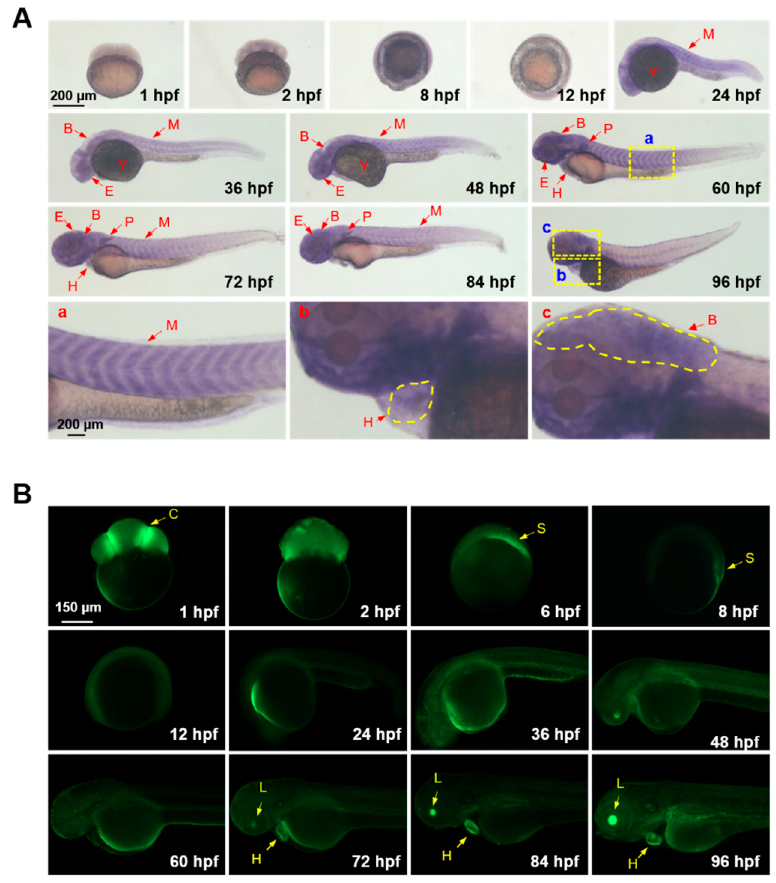
Figure 2. GCaMP6s expression and Ca 2+ signaling activity in embryos and larvae of the transgenic zebrafish. ( A ) Spatiotemporal expression patterns of GCaMP6s analyzed by whole-mount in situ hybridization. The magnified images indicate the expression of GCaMP6s in the myotome ( a ), heart ( b ) and brain ( c ). ( B ) Fluorescent microscope images indicating Ca 2+ signaling activities in the anatomical structures of zebrafish embryos and larvae. Lateral view of the early embryos (before 12 hpf) are shown. The embryos and larvae after 24 hpf were oriented as head to the left and dorsal to the top. B, brain; C, cleavage furrow; E, eyes; H, heart; L, lens; M, myotome; P, pectoral fin; S, embryonic shield; Y, yolk sac.